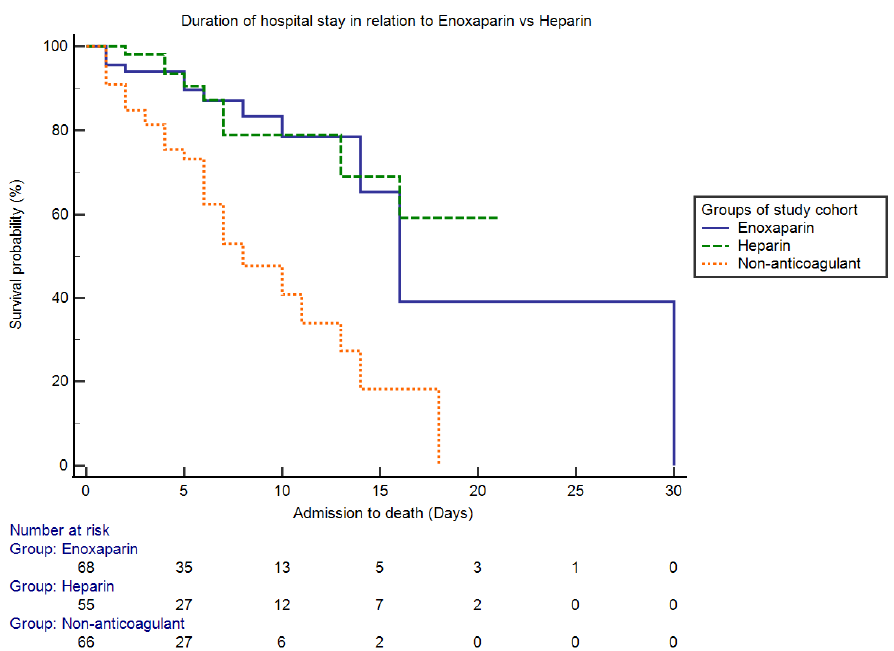
Figure 3. Kaplan–Meier curve showing the overall survival probability from hospital admission to death among the study cohort in relation to two groups of anticoagulants (enoxaparin vs. heparin). The Kaplan–Meier analysis showed that the 30-day in-HDU mortality was 19.1% for the enoxaparin group vs. only 16.4% for the heparin group ( p > 0.05). The median time of hospital stay was 19 days for the enoxaparin group and 16 days for the heparin group ( p < 0.05).